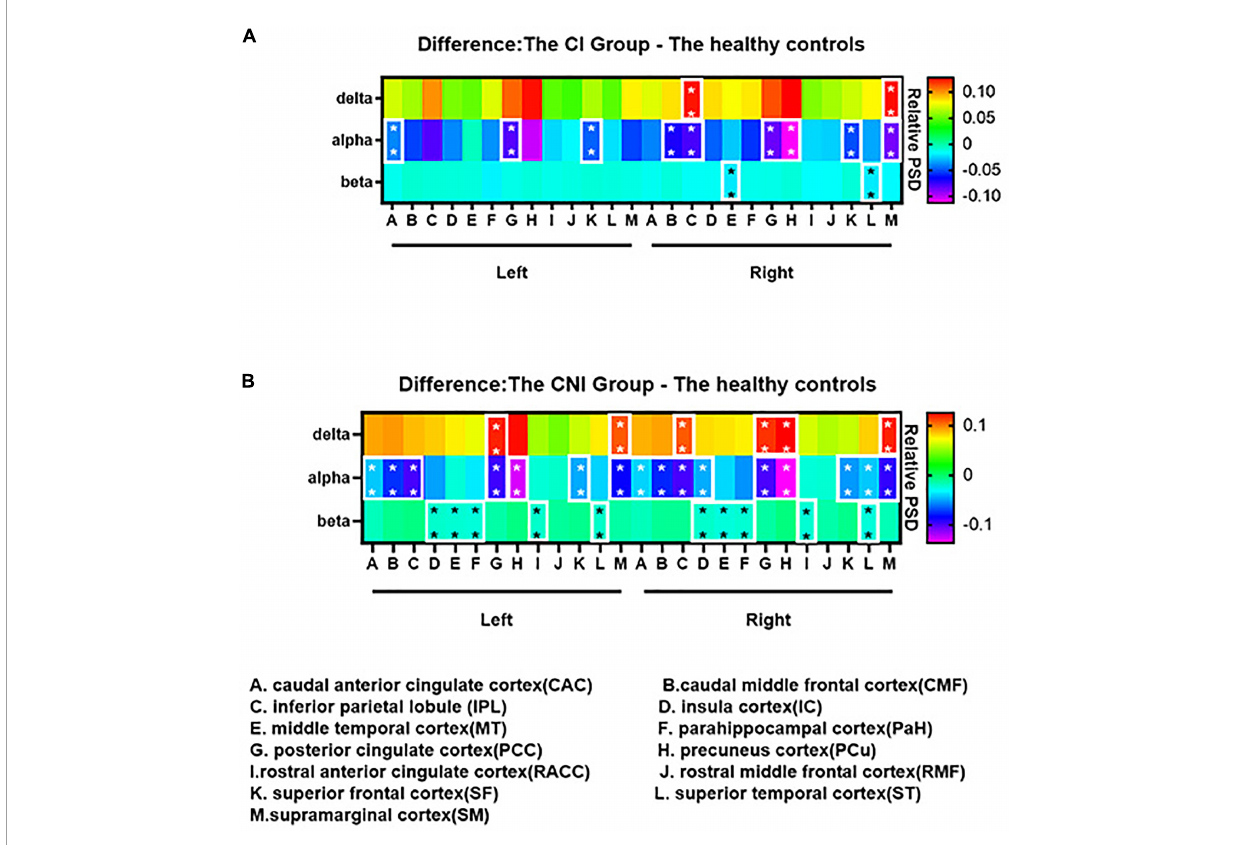
FIGURE4 Group differences of the spectral power among the delta, alpha and beta bands: (A) The cognitive impairment (CI) group - the healthy controls; (B) the cognitive nonimpairment (CNI) group - the healthy controls. The difference maps were color-coded, as the values increased, the color shifted from purple to red. In (A,B) , compared to the healthy controls, the spectral power of the CI group and the CNI group significantly decreased in the alpha band. We didn’t find any differences between the CI and the CNI group in all frequency bands. * p < 0.05, ** p < 0.01 after Bonferroni correction for multiple comparisons. The complete group differences of the spectral power from delta to fast ripple bands are shown in Supplementary Figure 2 .